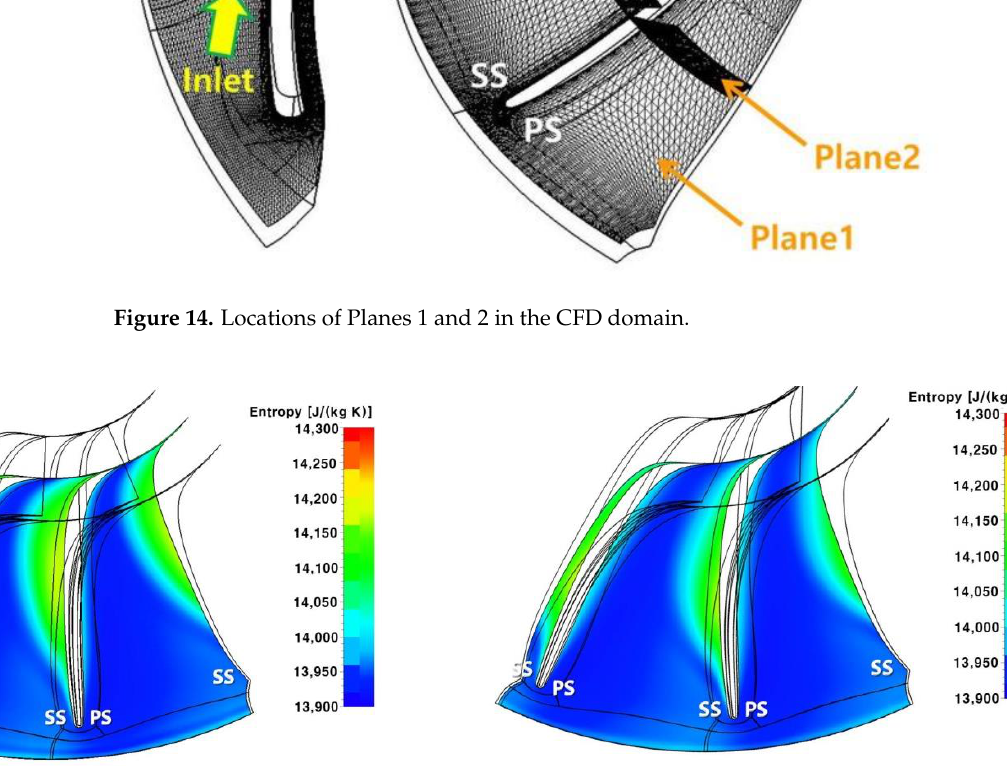
Figure 15. Comparison of entropy distribution at mid-span of the rotor (Plane 1): ( a ) original mod- el and ( b ) optimized model.